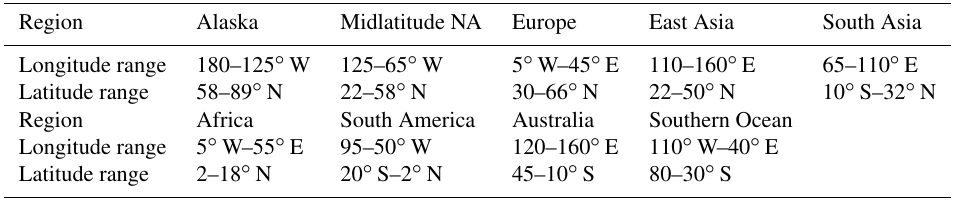
Table 4. Latitude and longitude ranges for seven